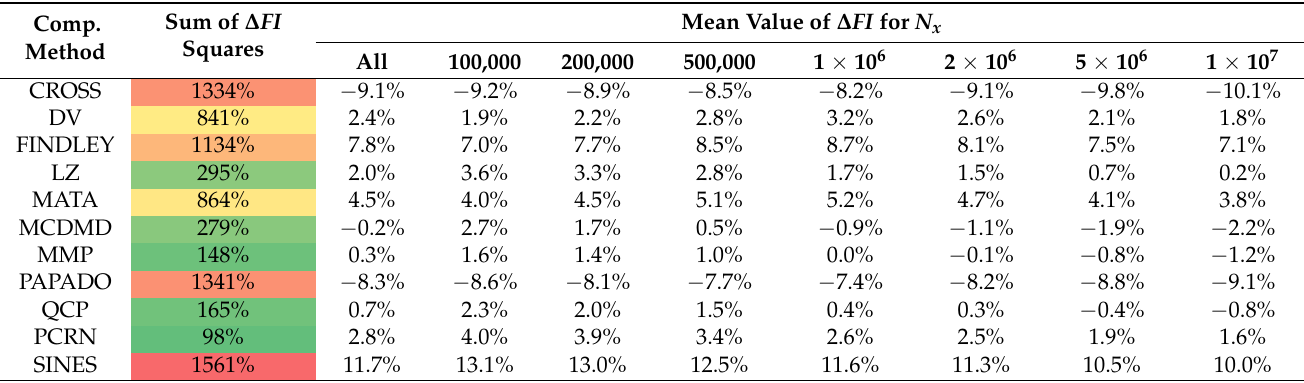
Table 8. Results of the ∆ FI statistics for 11 methods at different N x —sum of squares and mean values. Comp.